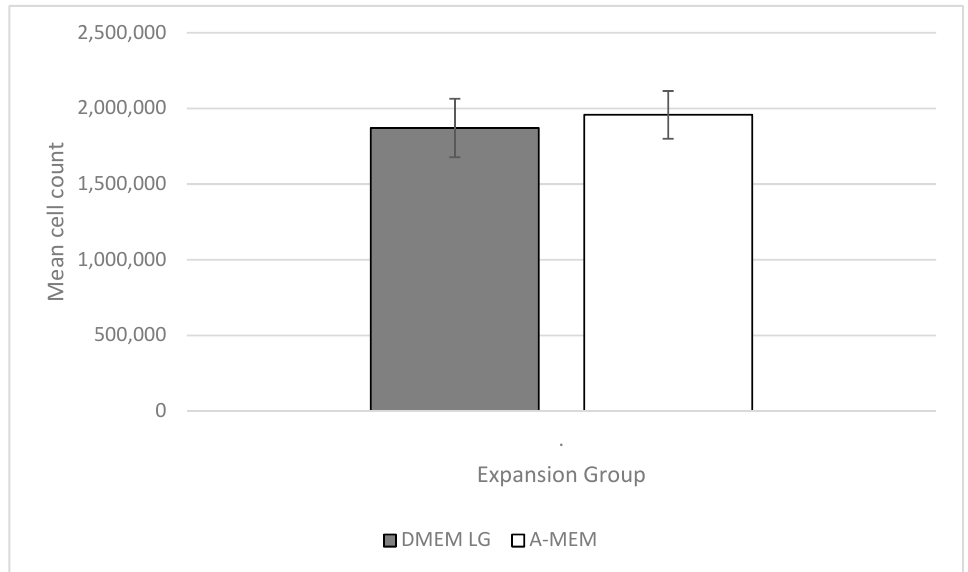
Figure 2. Mean cell count ( n = 6) for the cells expanded in DMEM LG (expansion group A) and expanded in α -MEM (expansion group B) +/ − SD. No significance between the two groups.